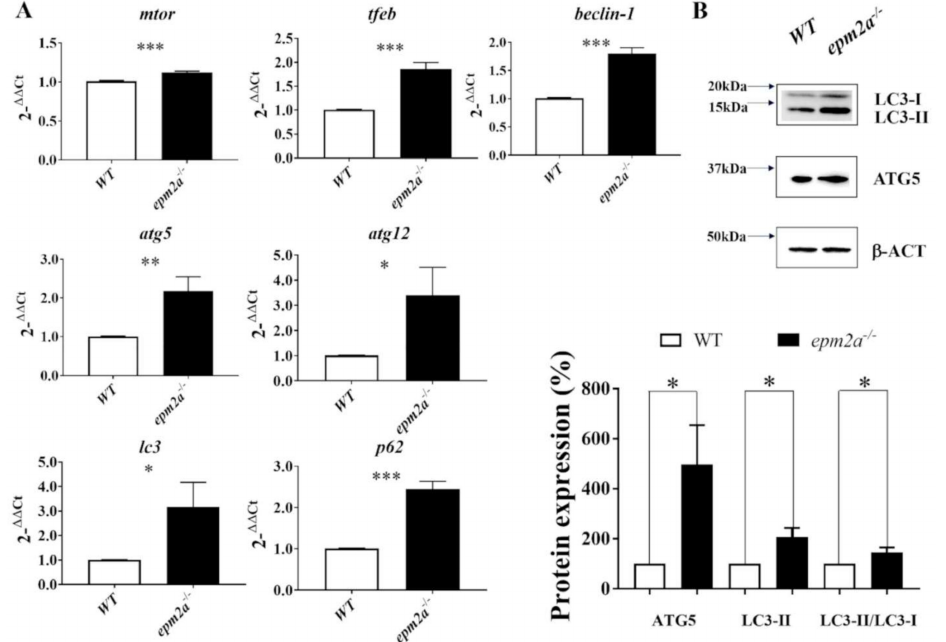
Figure 7. Analysis of autophagy in epm2a − / − zebrafish mutants. ( A ) qRT–PCR analysis of au- tophagy factors ( mtor , tfeb , beclin-1 , atg5 , atg12 , lc3 , and p62 ) normalized to β -actin in epm2a − / − larvae compared with controls at five dpf. Three independent RNA samples (each obtained from about 30–40 larvae) from controls and epm2a − / − mutant larvae at 120 hpf were analyzed. * p ≤ 0.05, ** p ≤ 0.01, *** p ≤ 0.001, calculated by Student’s t -test. The values are expressed as mean ± standard deviation (SD). ( B ) Three independent larval homogenates from controls ( n = 50) and epm2a − / − larvae ( n = 50) were tested by Western blotting for the expression of ATG5, LC3–I and LC3–II proteins. The levels of the different proteins were normalized to the expression of β -actin . * p ≤ 0.05 was calculated by Student’s t